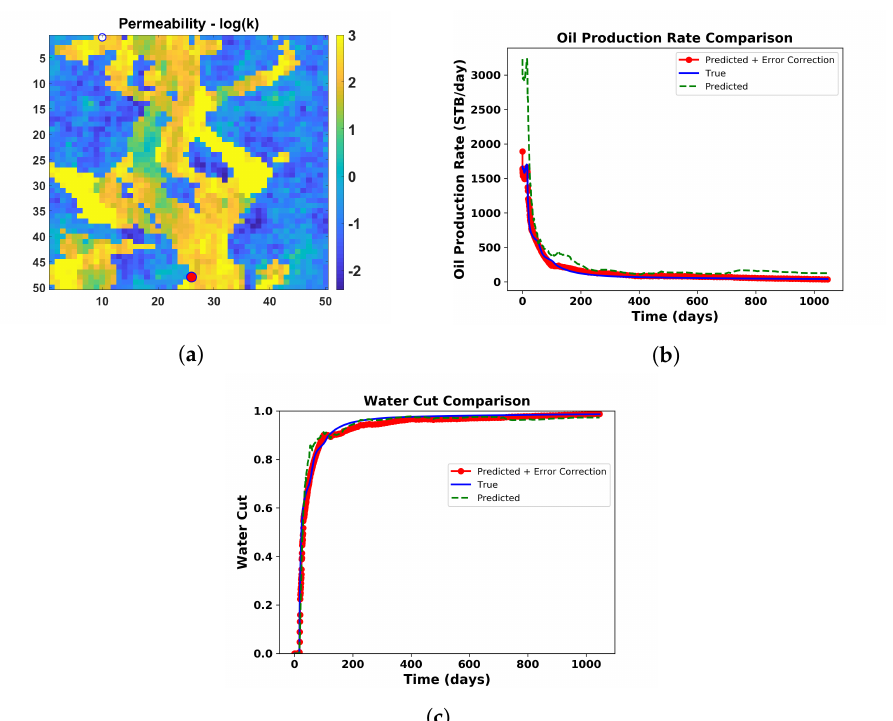
Figure 46. ( a ) Test case 2 with the producer well location at (26,48). ( b ) Comparison of oil production rate and ( c ) comparison of water cut, predicted using the global PMOR method alone (dotted green line) and after the implementation of the error correction model (red circled line) with the true solution (blue line).